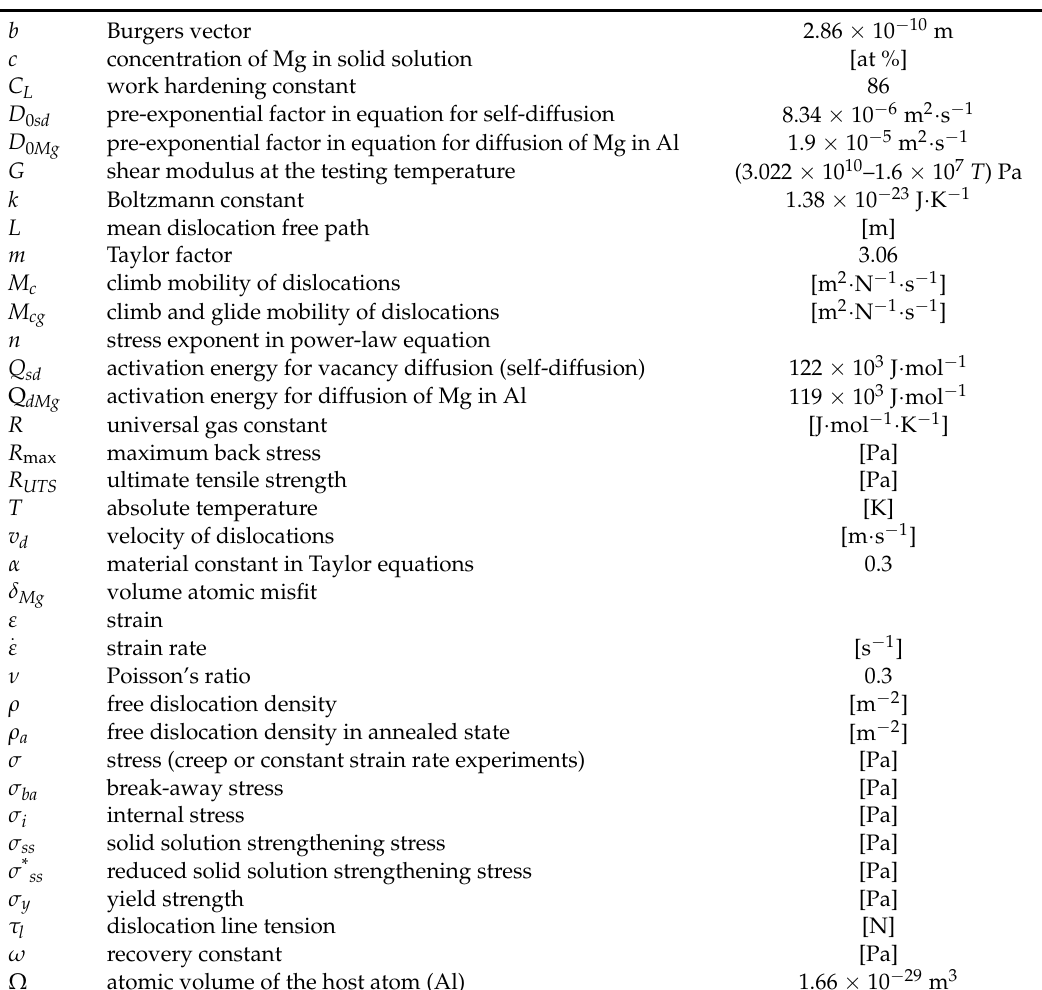
Table 1. List of fundamental